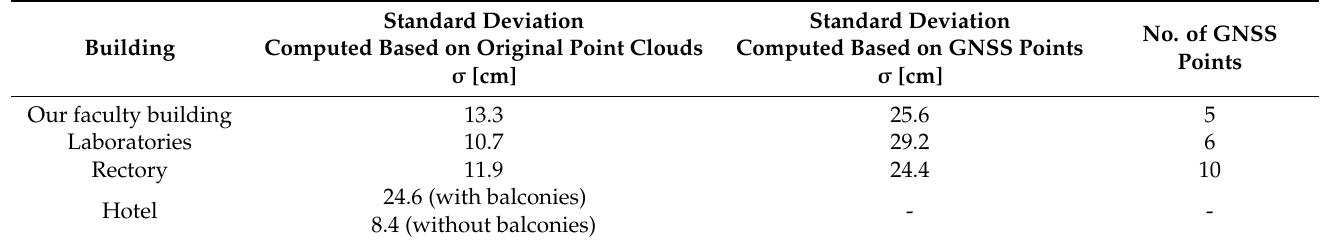
Table 7. Summary of the standard deviation obtained for the buildings UAS point cloud after computing the distances between each point and the final building 3D model and the standard deviation computed based on GNSS points